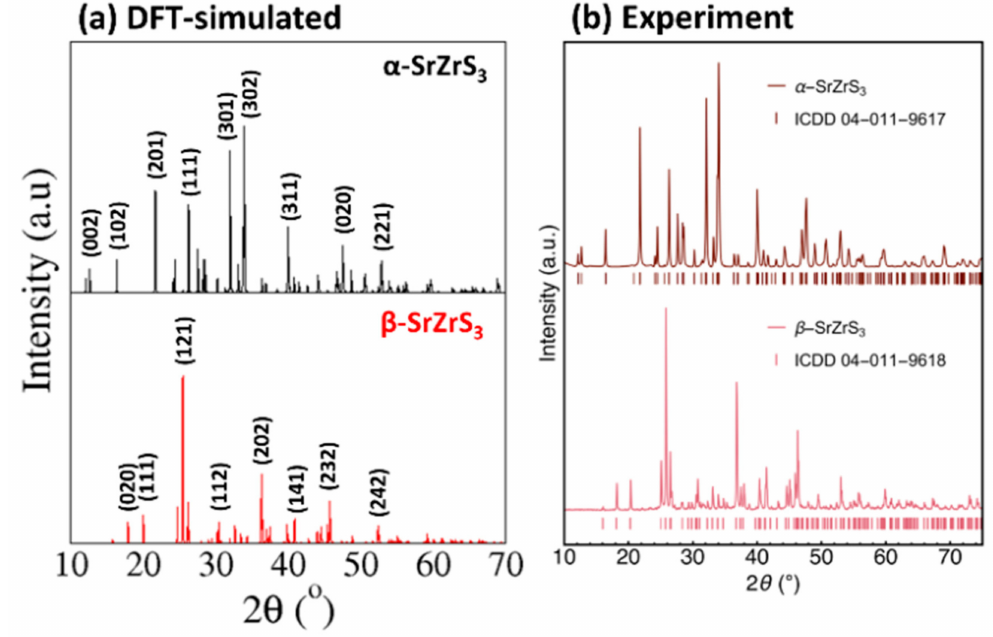
Figure 2. ( a ) DFT–simulated X–ray di ff raction pattern of α –SrZrS 3 and β –SrZrS 3 compared with ( b ) experimental XRD measurement